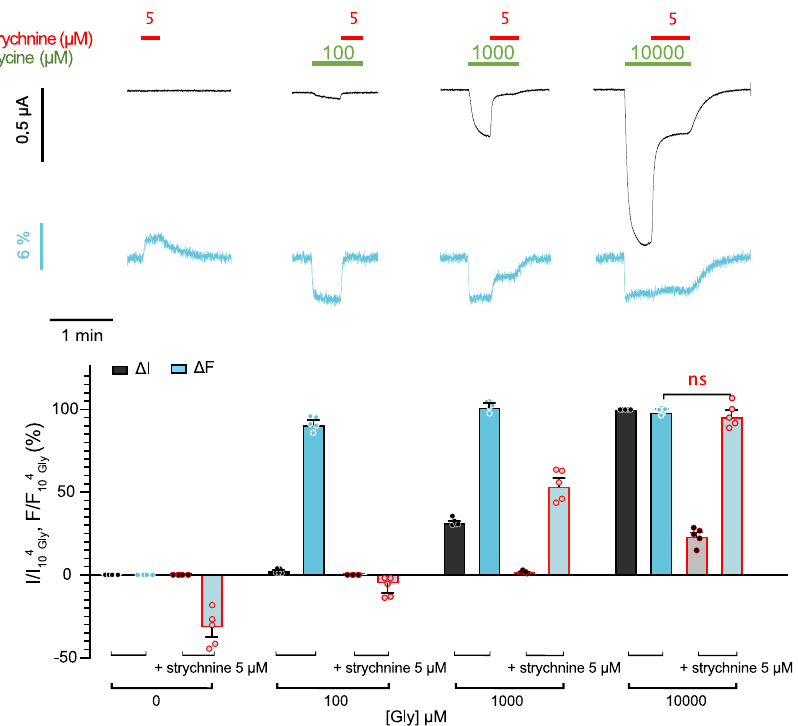
Fig. 5 | Differential inhibition of strychnine on fl uorescence and current on K143W/Q219C sensor on C41V GlyR. Upper left panel: Representative VCF recordingwheretheapplicationofstrychninealoneat5 µ Mtriggersa fl uorescence dequenching.Upperrightpanels:glycineisappliedatdifferentconcentrations fi rst alone (green bar) and then in a mixture with 5 µ M strychnine (red bar plus green bar),showingdifferentialstrychnine-elicitedinhibitionofcurrentand fl uorescence